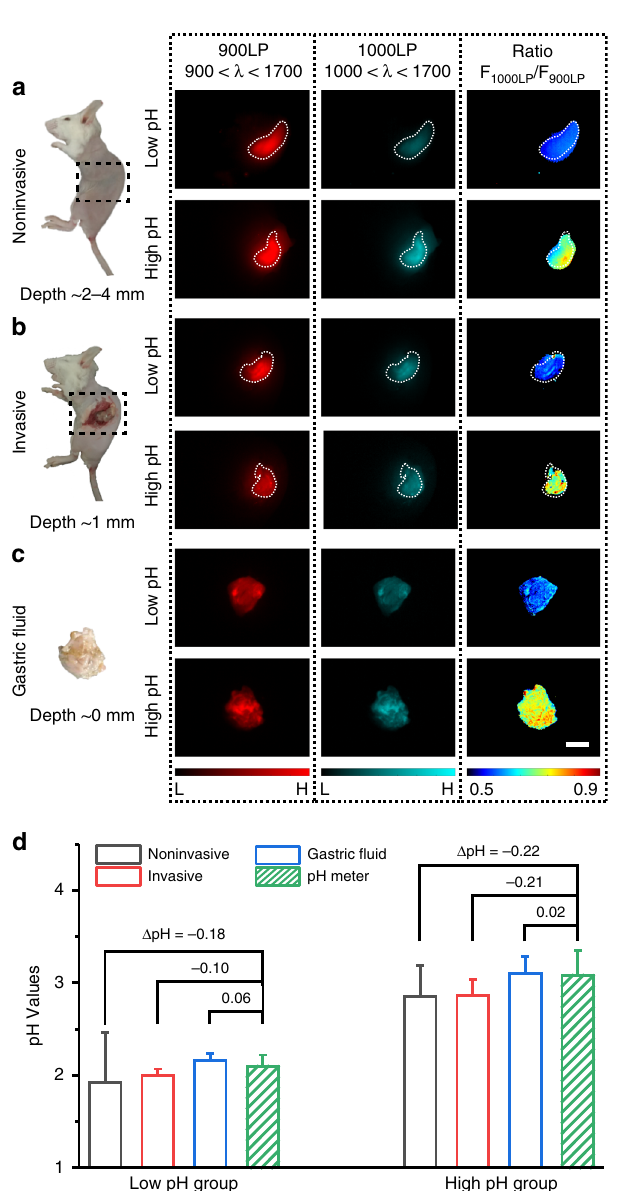
Fig. 7 In vivo ratiometric fl uorescence imaging of gastric pH. a – c Left: digital photographs of mice and dissected stomach denote three imaging modes. a noninvasive imaging at~2 – 4mm tissue depth; b invasive imaging of gastric fl uid covered by~1mm thickness of gastric wall; c imaging of exposed gastric fl uid. The measurement of tissue depth/thickness is shown in Supplementary Figure 24. Black dash square represents imaging window in mice. Right: fl uorescence images and corresponding ratiometric fl uorescence images of mice stomach at two different pH environments (red channel: 900 – 1700nm; cyan channel: 1000 – 1700nm; ratio channel: F 1000LP /F 900LP ). Color bar ranges from 5000 to 30000 for the red/cyan channel in a and b , 0 – 30000 for the red/cyan channel in c . The detailed imaging parameters for each image are listed in Supplementary Table 1. Scale bar, 5mm. d , Comparison of pH values in mice stomach measured by ratiometric fl uorescence imaging and standard pH meter. The true gastric pH determined by pH meter is higher than that of simulated gastric fl uid due to the buffering effect (see Methods). Ratios derived from the ratio images are converted to pH values by means of the calibration functions at corresponding depth (Supplementary Note 3). Δ pH = average pH resolved from ratiometric imaging − average pH measured by standard pH meter. Detailed pH data are summarized in Supplementary Table 7. Data point with its error bar stands for mean±s.d. derived from n = 3 biologically independent mice. Source data are provided as a Source Data fi le NATURE COMMUNICATIONS| (2019) 10:1058